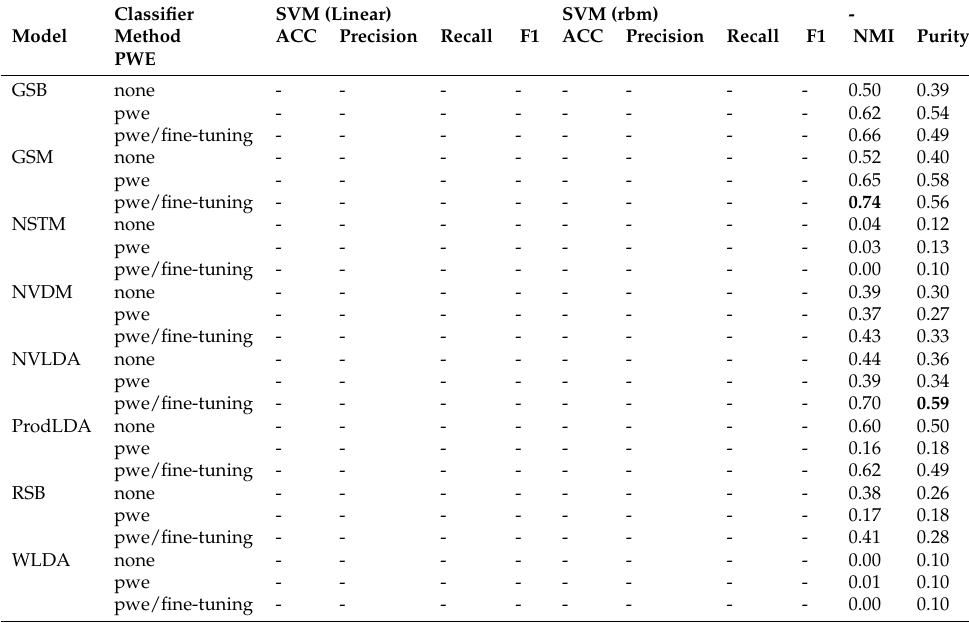
Table 32. Classification and Clustering performance on